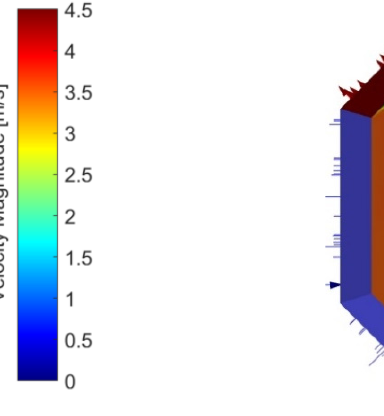
Figure 5. Calculated flow with south–west wind.